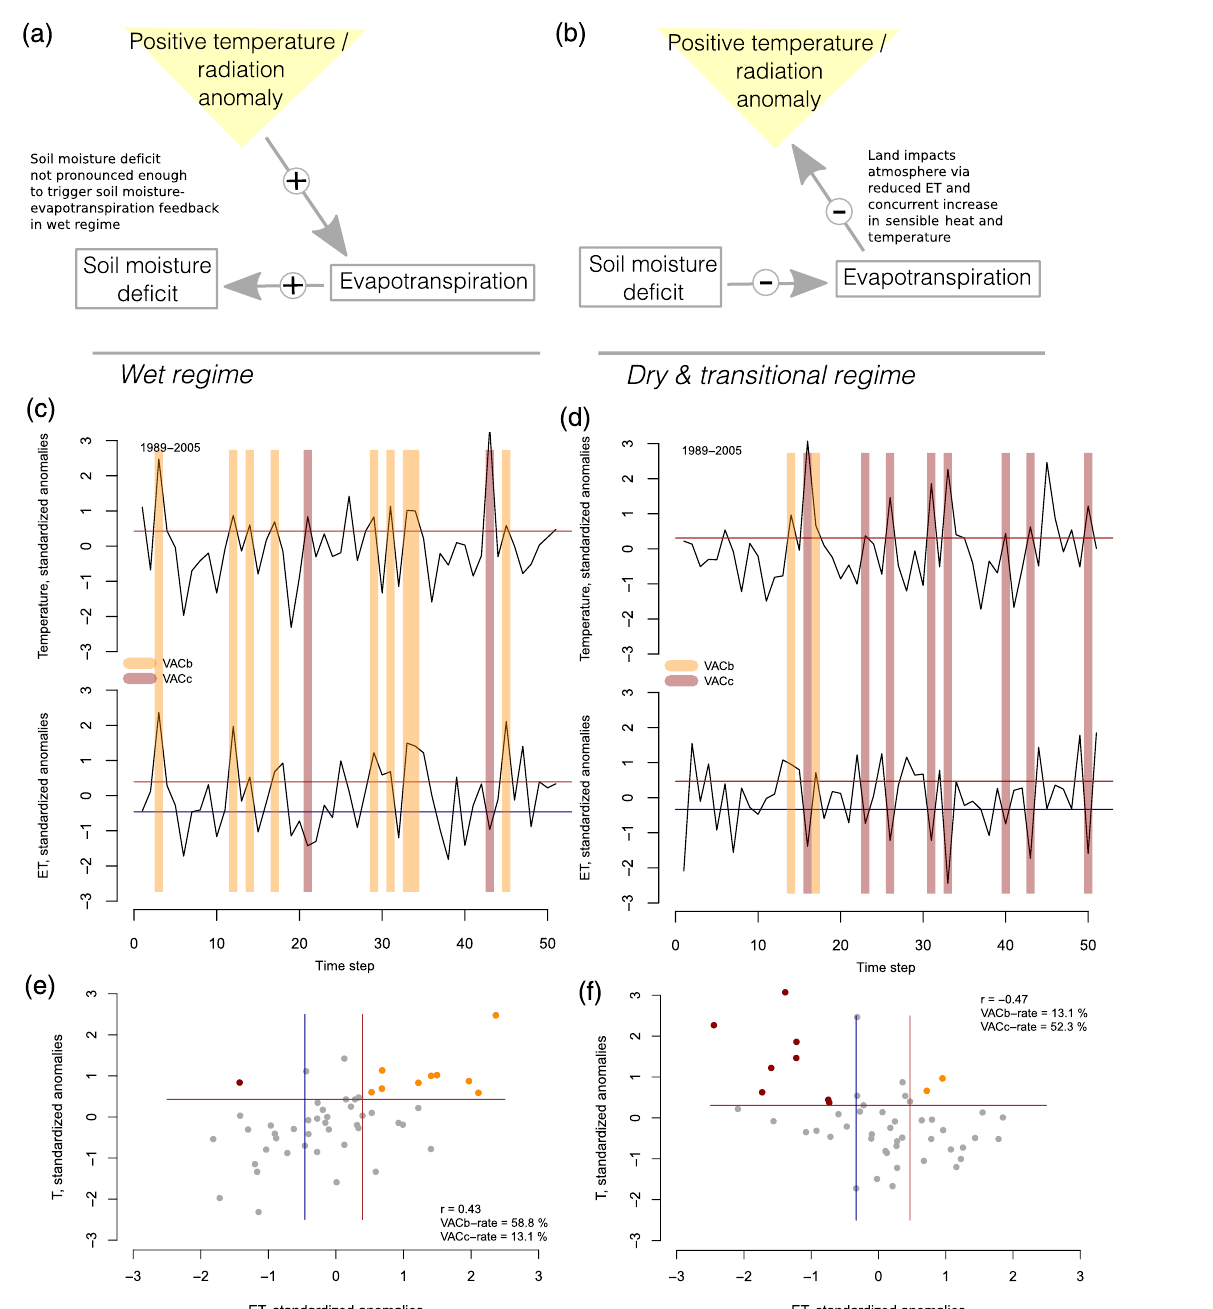
Figure 1. Illustration of qualitatively contrasting warm season temperature–evapotranspiration ( T –ET) coupling in global climate models. (a, b) Conceptual illustration of T –ET coupling in (a) wet and (b) dry and transitional regimes. In wet regimes T and ET are positively associated (atmosphere impacts land), while in dry and transitional regimes T and ET are negatively associated due to soil moisture feedbacks (i.e. land impacts atmosphere via reduced ET and concurrent increases in sensible heat and T ). (c) – (f) Different CMIP5 models show contrasting T –ET coupling behaviour in a midlatitude region in summer (central Europe, spatial average, JJA, 1989–2005): (c, e) NorESM1- M produces predominantly wet regimes, i.e. a positive T –ET coupling, while (d, f) ACCESS1-3 produces predominantly dry regimes (negative T –ET coupling), illustrated as time series (c, d) and in the T –ET plane (e, f) . Dark red lines in (c) – (f) indicate upper threshold (th upper ) for T and ET ; dark blue lines indicate lower threshold (th T ) (70th and 30th percentile in each individual time lower